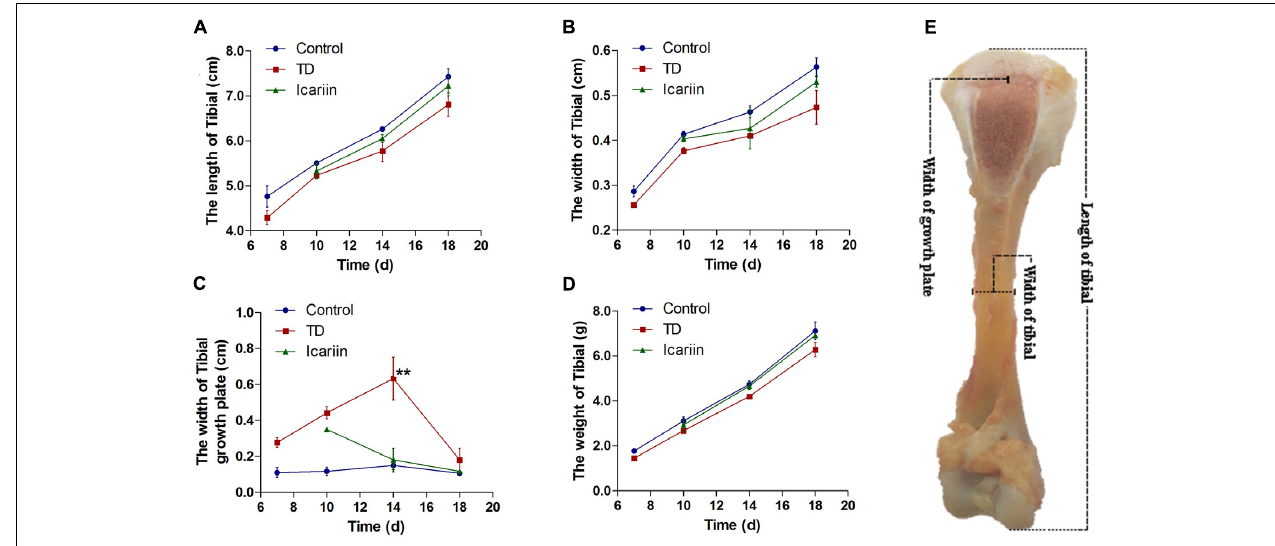
FIGURE 4 | The overall parameters analysis of tibia bone. (A–D) Correlation analysis among length of tibia, width of tibia, weight of tibia, and width of tibial growth plate were recorded with Pearson test during the experiment from days 7 to 18. (E) Measurement of width of growth plate, width of tibia and length of tibia bone. ∗∗ P < 0.01.